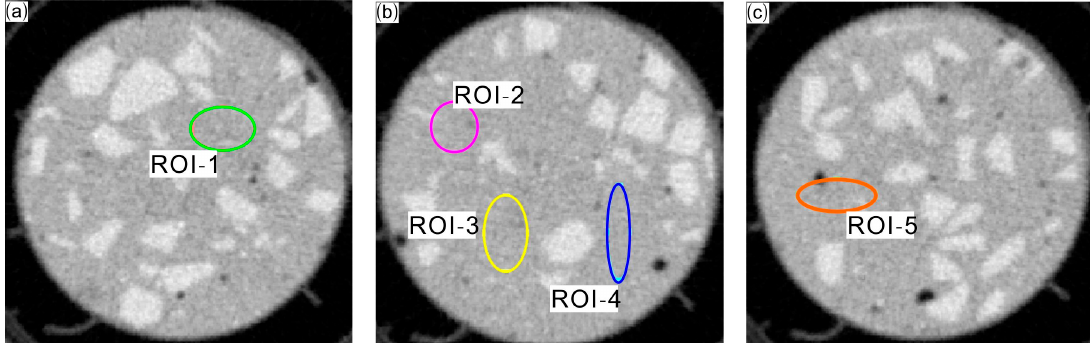
Figure 11. Determination of the positions of ROI in the CT images. ( a – c ) ROI-1 was located in the bottom slice, ROI-2–4 were located in the middle slice, and ROI-5 was located in the top slice.